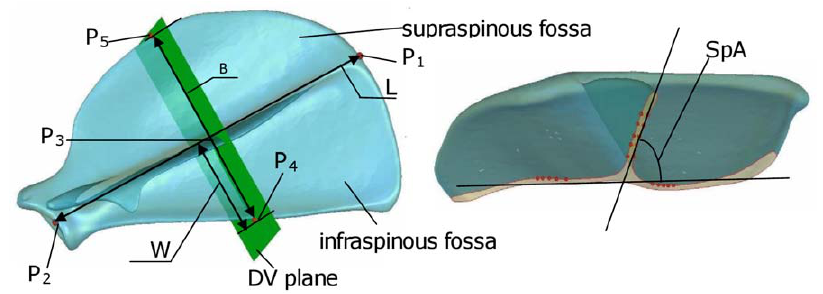
Figure 7. Reference features and parameters used to quantify MVs. P 1 : intersection point of spine and dorsal border; P 2 : centre of glenoid cavity; P 3 : mid-point between P 1 and P 2 ; P 4 : intersection point of caudal border with DV plane; P 5 : intersection point of cranial border with DV plane.